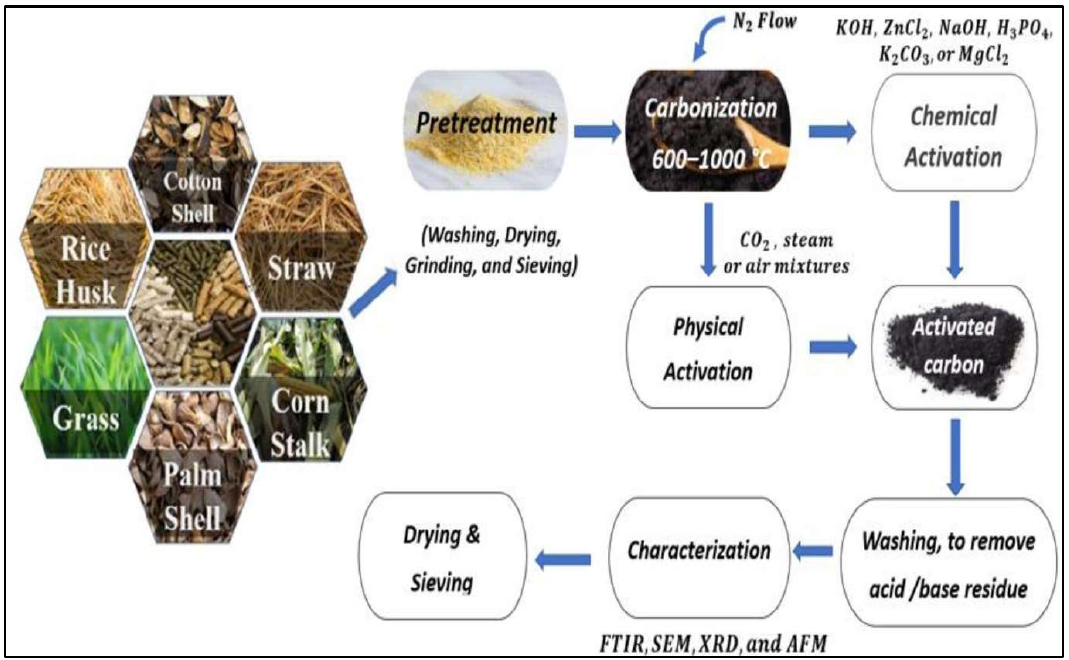
Figure 3. Fabrication routes of agricultural-based-activated carbon from different precursors. Adapted from [78] .